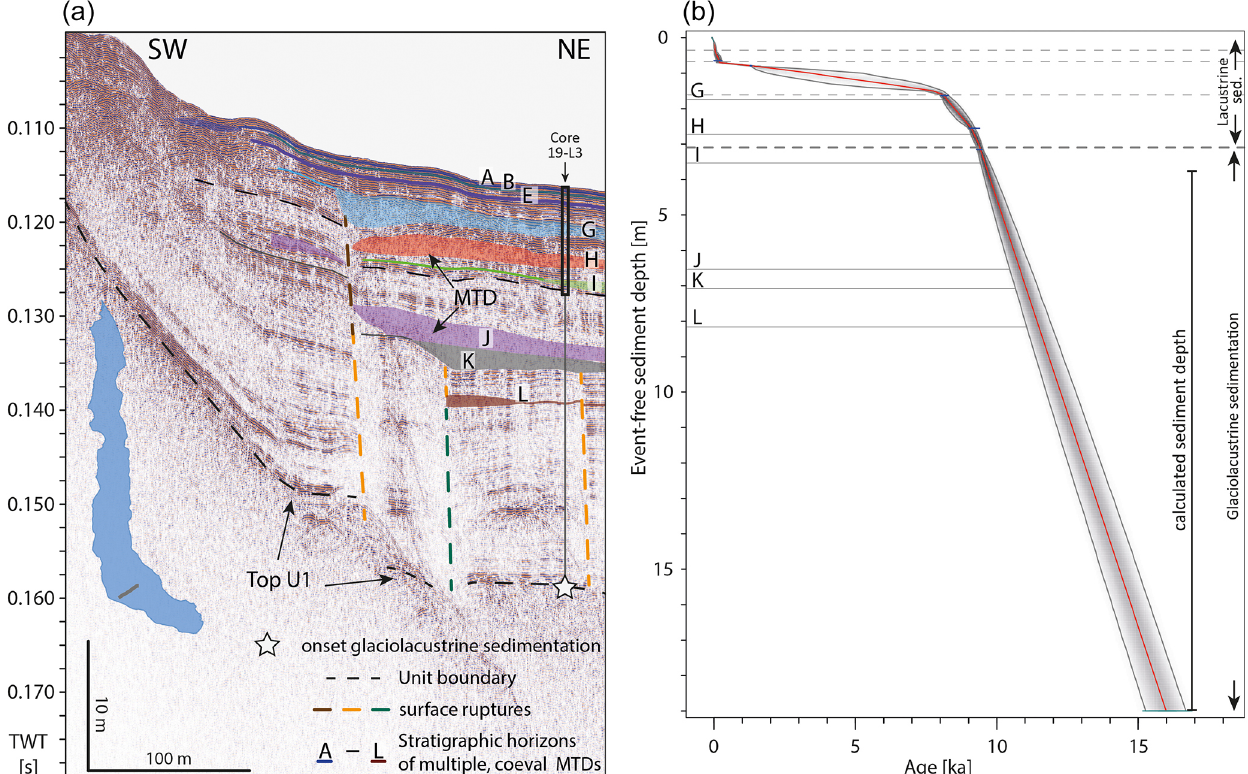
Figure 4. Extension of the paleoseismic record at Achensee. (a) Earthquake imprints are expressed as horizons of multiple coeval MTDs and subvertical subaqueous surface ruptures (Oswald et al., 2021a). The vertical thin gray line shows the prolongation of the previously published sediment core ACH19-L3 towards the interpreted onset of glaciolacustrine sedimentation at the top of unit 1. Inset shows the orientation of the seismic profile on Achensee. (b) Extension of the age–depth model of core ACH19-L3 towards the assumed begin of glaciolacustrine sedimentation ( ∼ 15–17ka after Ivy-Ochs et al., 2008). Projected event-free sediment depths of event horizons J–L are marked by horizontal lines. Dashed horizontal lines represent stratigraphic boundaries. The calculated event-free sediment depth results from the depth calculation between the base of the core and the interpreted onset of glaciolacustrine sedimentation of TWT in seismic data assuming an acoustic velocity of 1610ms − 1